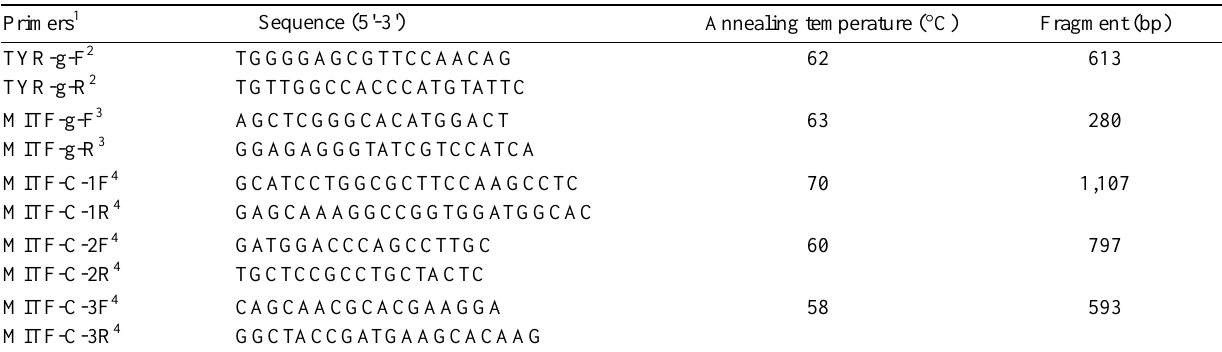
Table 1. Primers for MITF and TYR genotyping and cloning of MITF Primers